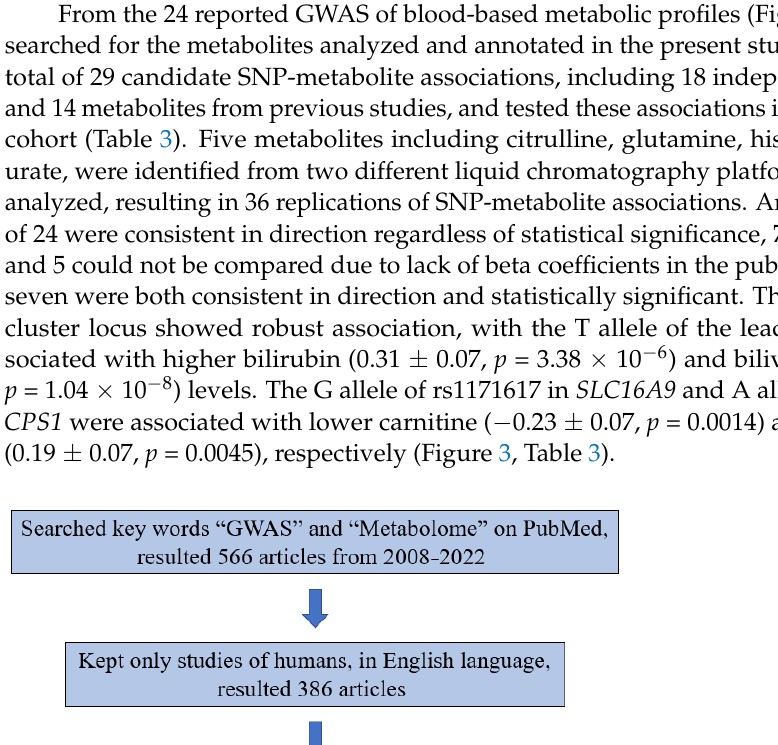
Figure 2. Diagram of literature review.